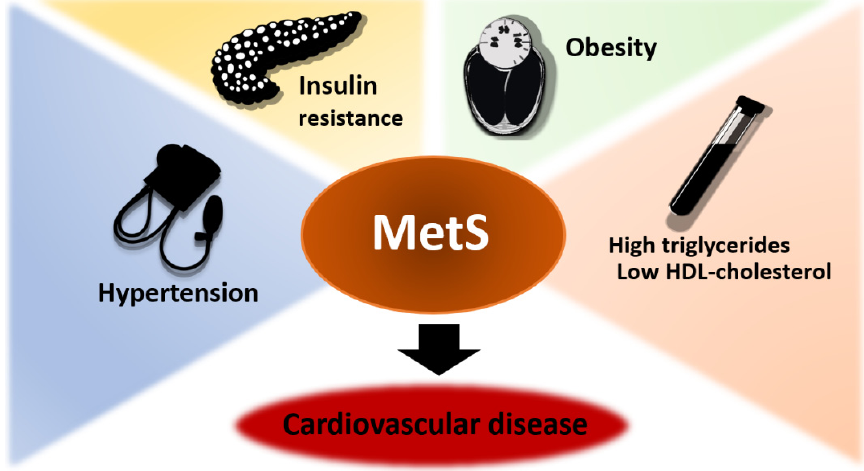
Figure 1. Metabolic syndrome (MetS): key-factors and cardiovascular risk.